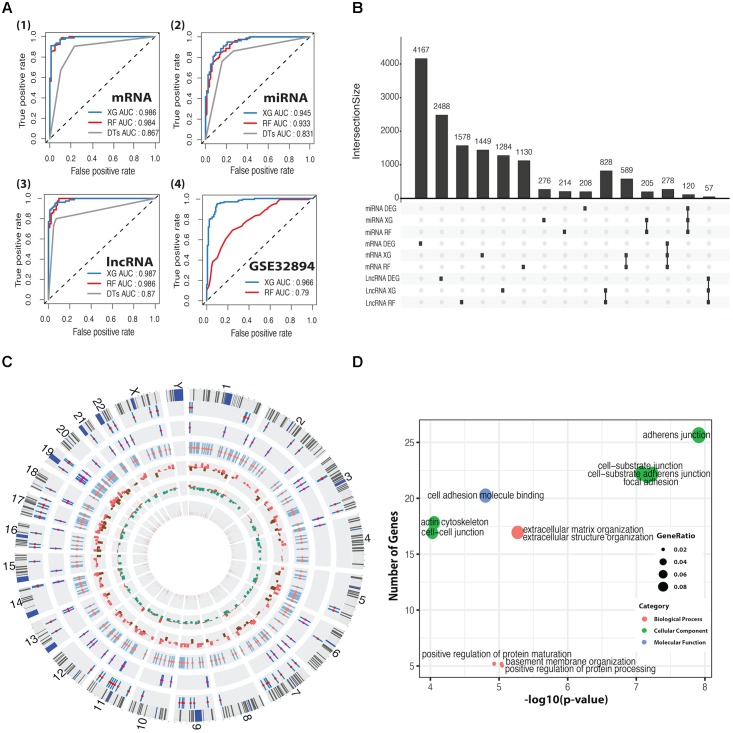
ROC curves for classification predictors and information for differentially expressed feature genes (DEFGs). (A) ROC curves for XGBoost, RF, and DTs classifiers in mRNA, miRNA, lncRNA, and GSE32894 dataset. (B) An UpSet plot for intersected information between DEGs and the feature genes obtained by XGBoost and RF. (C) A Circos plot for 278 DEFmRNAs with gene symbols, chromosomal cytobands, and other information. From inside to outside, variable weight from RF (brown), fold change from DEGs (up in red, down in green), p-value from univariate Cox’s proportional regression analysis (p > 0.05 in red, p < 0.05 in brown), DEFlncRNAs (coral), DEFmiRNAs (deep pink), DEFmRNAs (red). (D) Bubble plots for enriched GO terms generated from 278 DEFmRNAs. The x-axis represents the –log10(p-value) of each term and the y-axis represents the number of genes in each term.